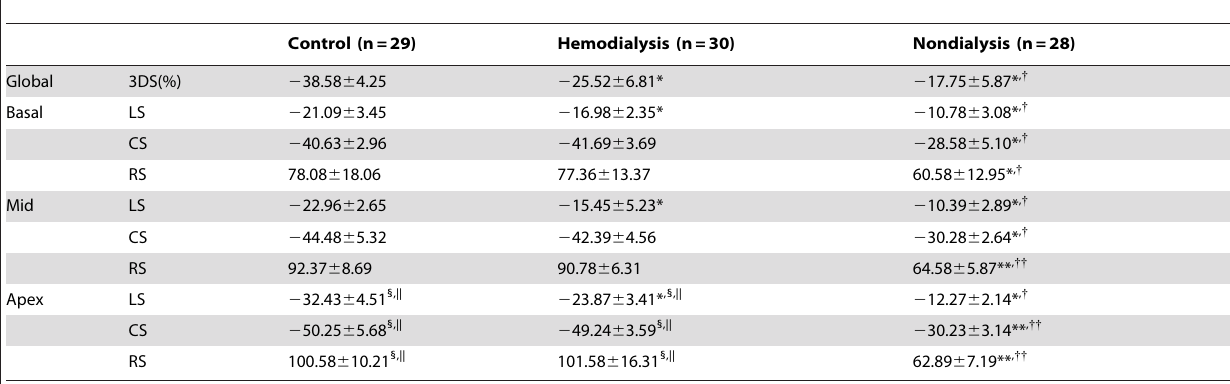
Table 3. 3D-STE parameters of the Uremia and Control